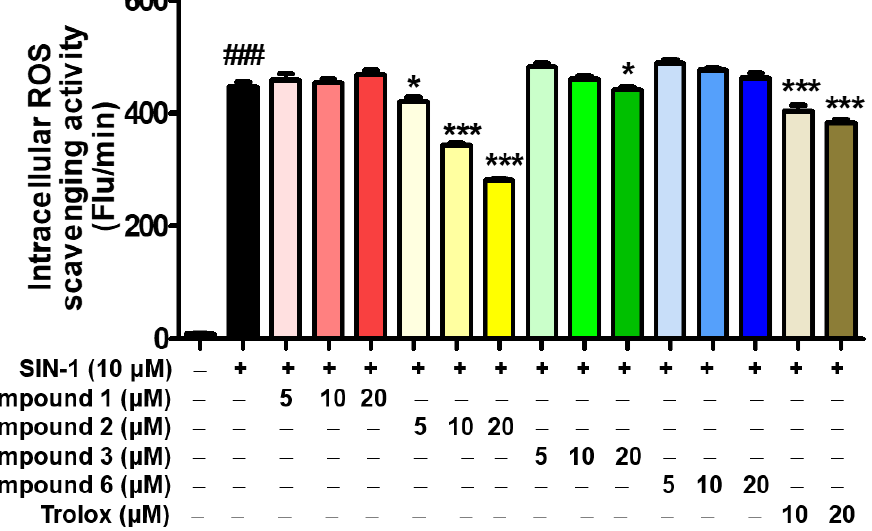
Figure 13. ROS scavenging abilities of analogs 1 – 3 and 6 . A DCFH-DA assay was used to assess ROS levels and trolox was used as the positive control. The abilities of analogs 1 – 3 and 6 to scavenge oxidative stress induced by 10 µM SIN-1 were assessed using B16F10 cells. Cells were pretreated with 1 – 3 , 6 , or trolox for 2 h and then treated with 10 µM SIN-1. # and * indicate significant differences between columns: ### p < 0.001 for cells treated with SIN-1 versus non-treated controls; * p < 0.05 and *** p < 0.001 for cells treated with SIN-1 versus SIN-1-stimulated and analog 1- , 2- , 3- , 6- , or Trolox-treated cells.